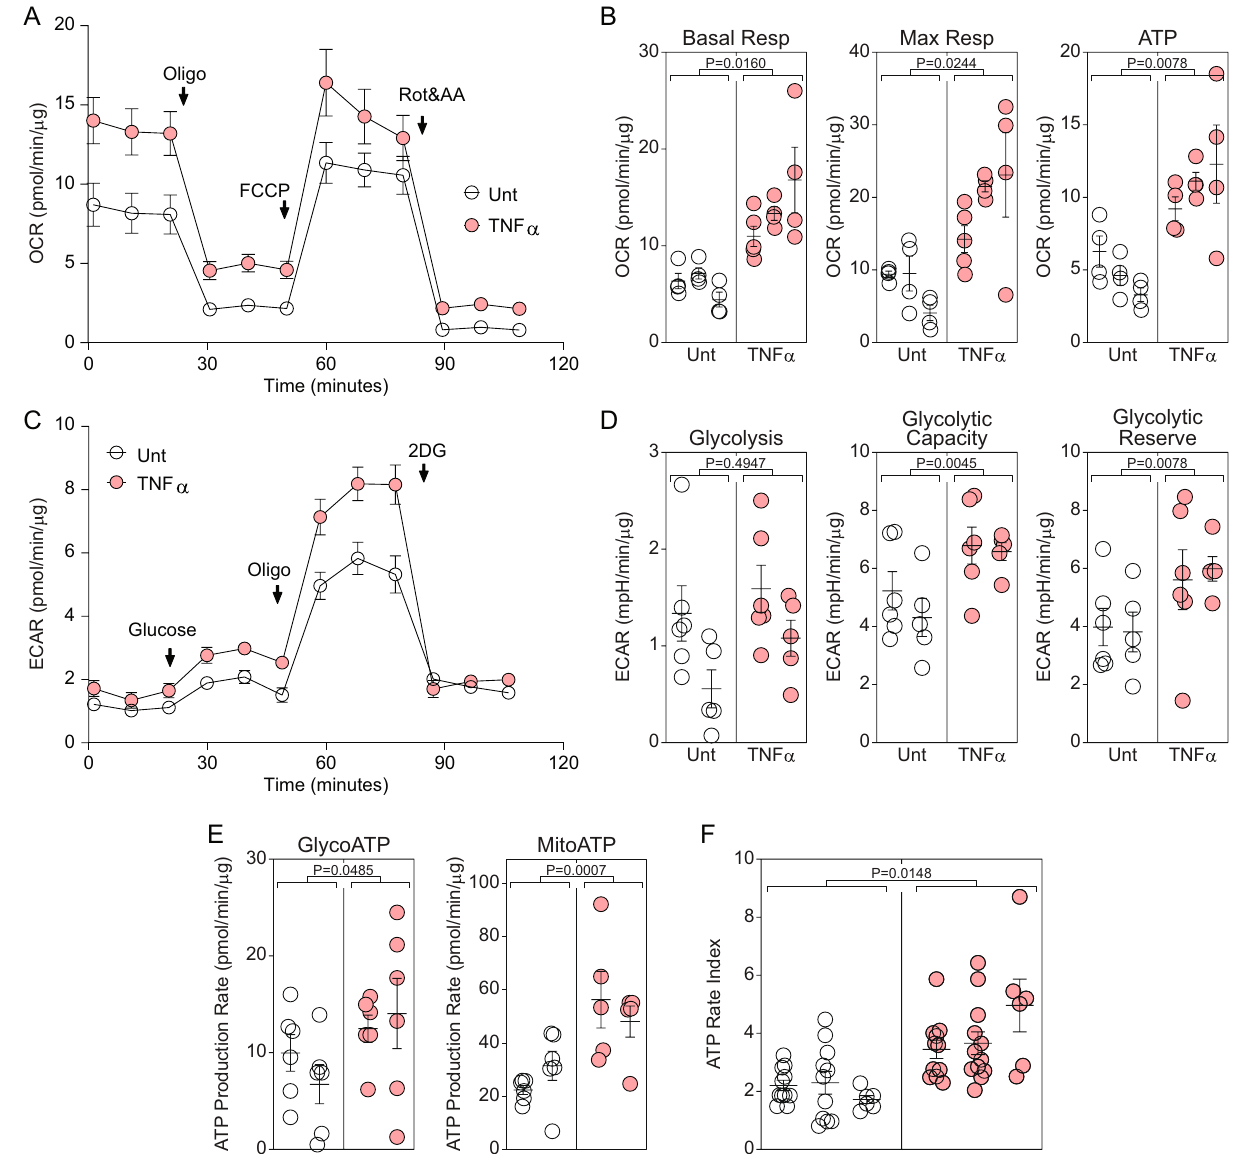
Figure 2. TNFα increases oxidative phosphorylation in quiescent astrocytes. ( A ) Astrocytes were left untreated (white symbols) or stimulated with TNFα (10 ng/mL for 24 h) (red) and then the realtime oxygen consumption rate (OCR) was measured using the Seahorse XF analyzer. Data are normalized to total protein (μg) present in the wells at the end of the analysis and represent at least 3 independent experiments. ( B ) Combined OCR measurements from technical replicates in 3 separate experiments are shown as mean ± SEM for the replicates; each symbol represents one well. P-values were calculated using mixed model nested t-tests. ( C ) Astrocytes were left untreated (white symbols) or stimulated with TNFα (10 ng/mL for 24 h) (red) and then the realtime extracellular acidification rate (ECAR) was measured. Data are normalized to total protein (μg) per well and represent at least 3 independent experiments. ( D ) Combined ECAR measurements from technical replicates in 2 separate experiments are shown as mean ± SEM for the replicates; each symbol represents one well. P-values were calculated using mixed model nested t-tests. ( E ) The contribution of glycolytic or mitochondrial ATP production was analyzed by Seahorse in quiescent cells stimulated with TNFα (10 ng/mL for 24 h) (red) or vehicle (DMSO; white). Data are normalized to total protein and shown as mean ± SEM from at least 6–8 replicates in two separate experiments. P-values were calculated using mixed model nested t-tests. ( F ) The ratio of mitochondrial ATP production rate to glycolytic ATP production rate was calculated in at least 8 technical replicates in 3 separate experiments and shown as mean ± SEM for the replicates. P-value was calculated using mixed model nested